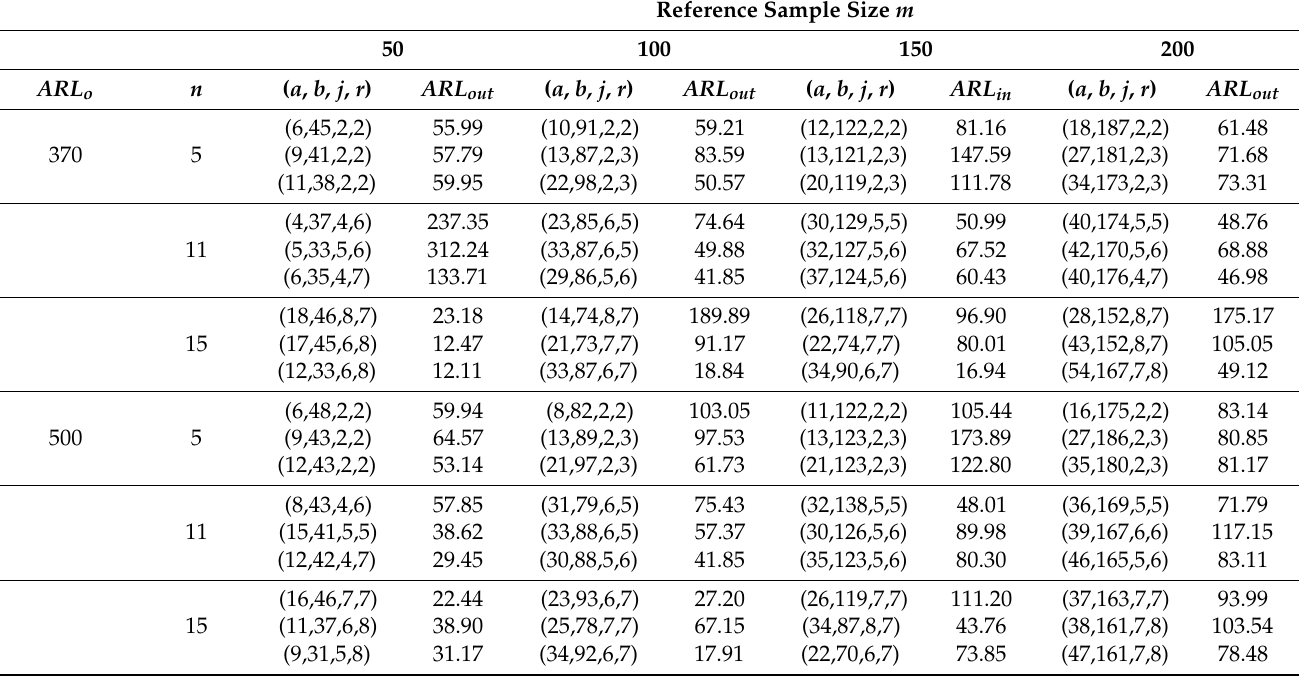
− , C 3 − and C 4 − charts for a given design. 1 1 1